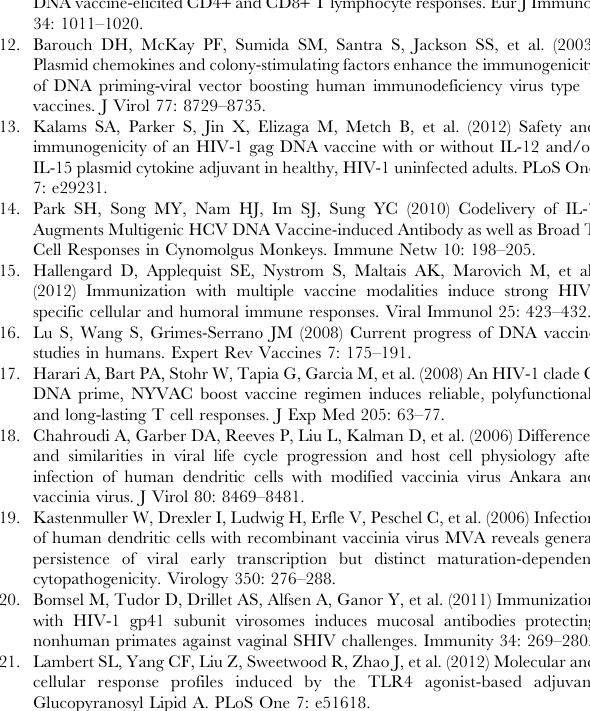
Table S1 Percentage positive of gated and live CD4 and CD8 T cells that secreted cytokine in response to peptide pools Env 1, Env 2, Gag 1 or Gag 2. (TIF)